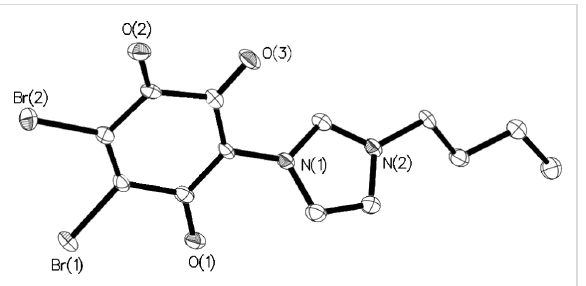
Figure 3: Solid-state molecular structure of compound 3 . Selected bond distances [Å]: O(1)–C 1.228(4), O(2)–C 1.204(4), O(3)–C 1.241(4). Figure 4: Formation of molecular layers in the crystal